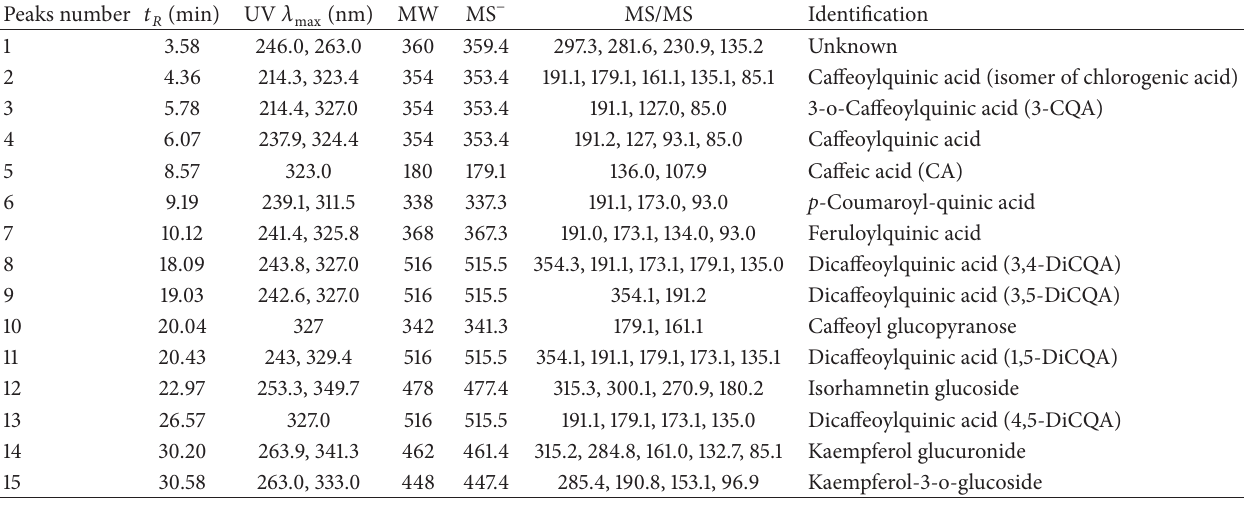
Table 1: Identification of phenolic compounds in H. tuberosus leaves by HPLC-MS/MS.